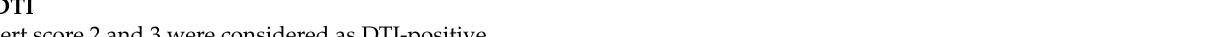
Table 4. 2 × 2 Contingency tables for diagnostic accuracy comparing conventional mpMRI to DTI. ( a ) DTI; ( b ) mpMRI; ( c ) DTI; ( d )